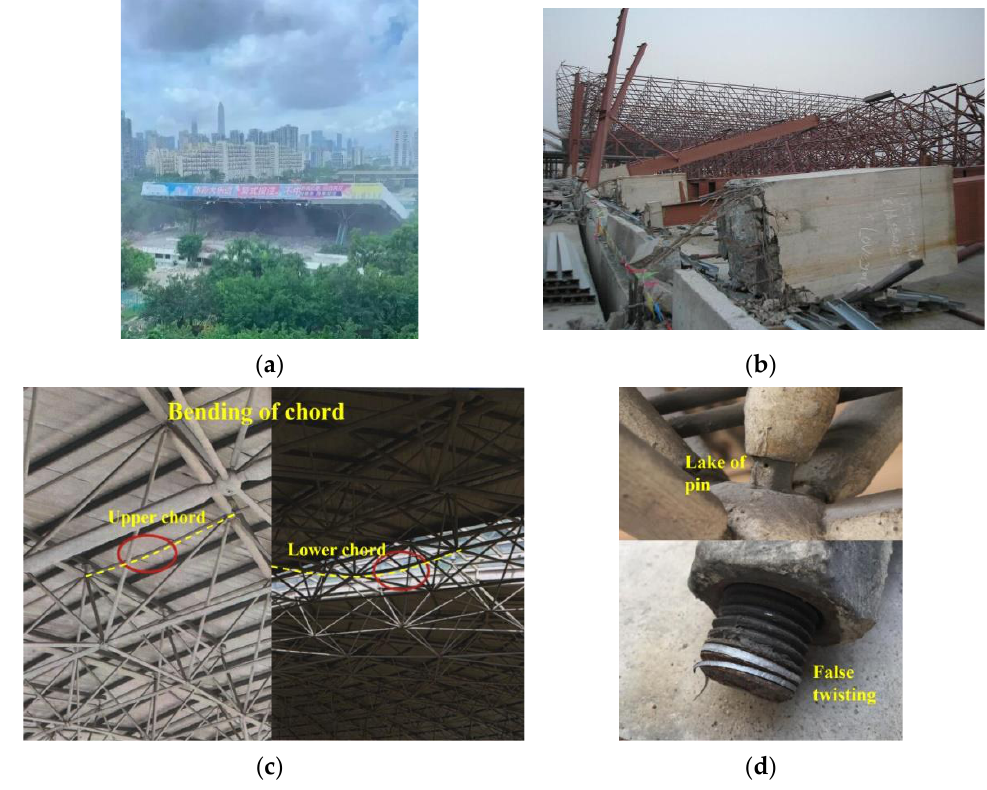
Figure 2. Accidents and abnormal cases in the space frame structure. ( a ) Gymnasium collapse; ( b ) Convention center collapse; ( c ) Member defect; ( d ) Joint defect [6].